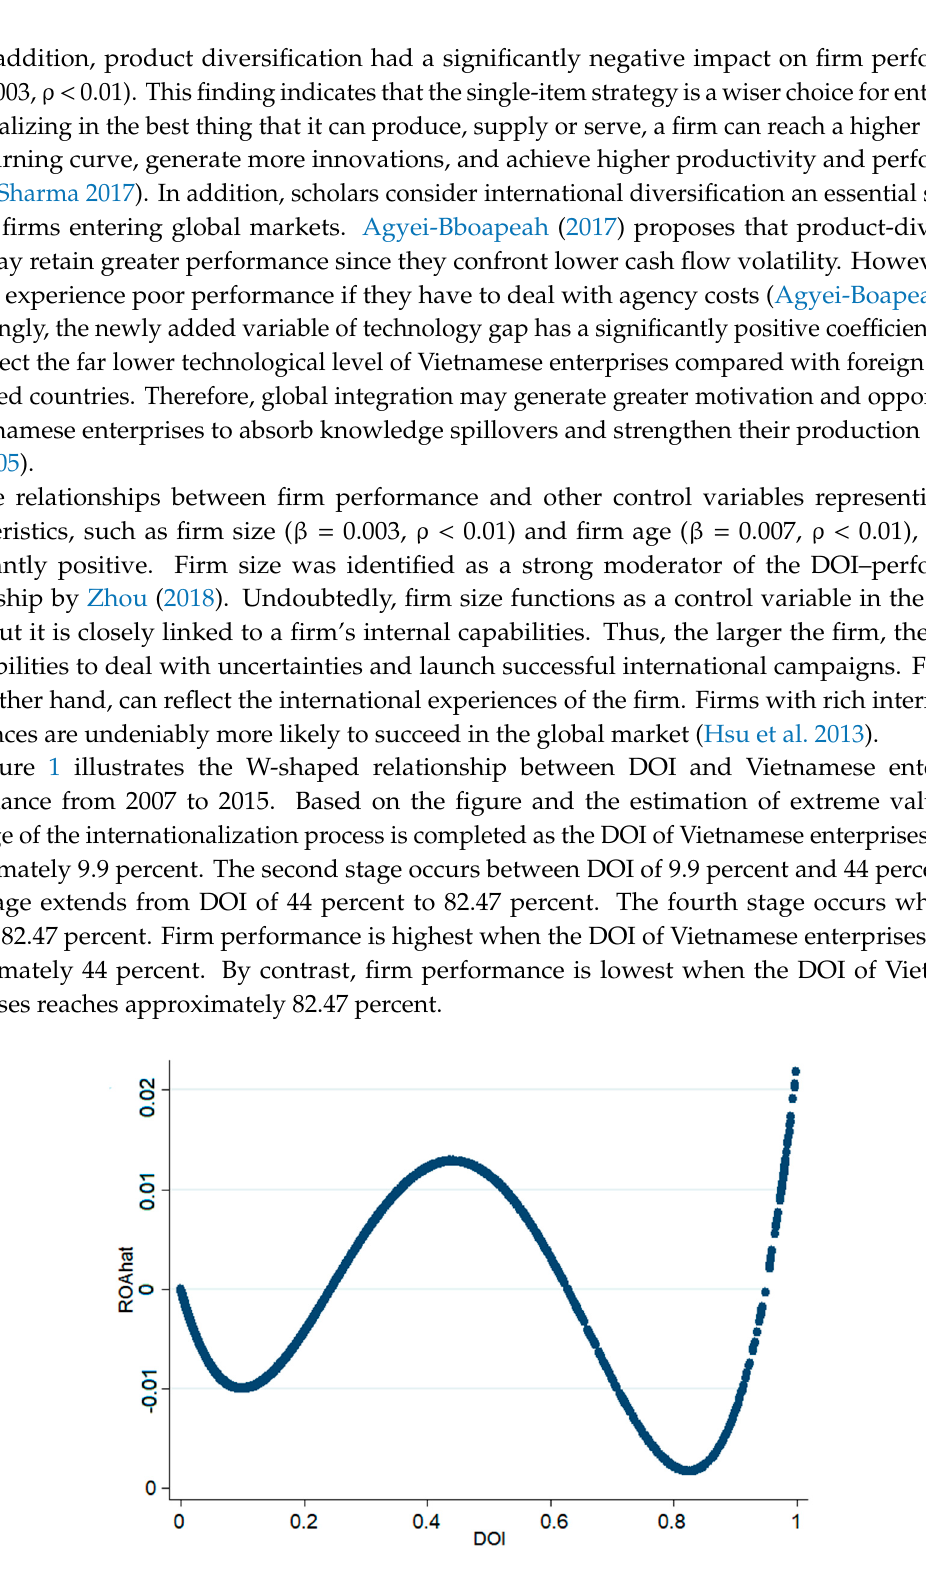
Figure1. TherelationshipbetweenthedegreeofinternationalizationandVietnamesefirms’performance from 2007 to 2015 (Notes: ROAhat is estimated according to the coe ffi cients of regression Figure 1. The relationship between the degree of internationalization and Vietnamese firms’ performance from 2007 to 2015 (Notes: ROAhat is estimated according to the coefficients of regression results).